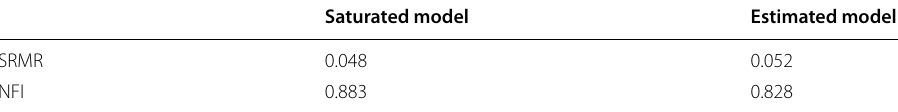
Table 5 Model fit